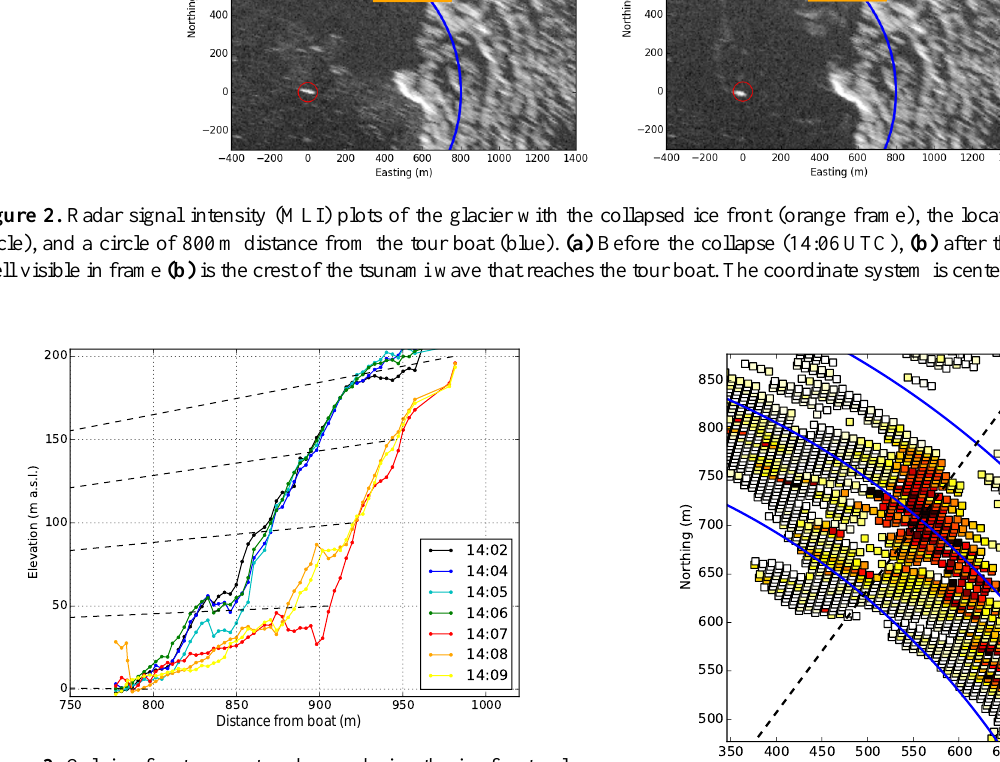
Figure 3. Calving front geometry change during the ice front col- lapse measured with the TRI. The glacier surface is shown along a profile indicated in Fig. 4. The ice front collapse happened between 14:06 and 14:07UTC. The dashed black lines indicate rays starting from the tour boat, and are used to determine the height of features in Fig. 5.